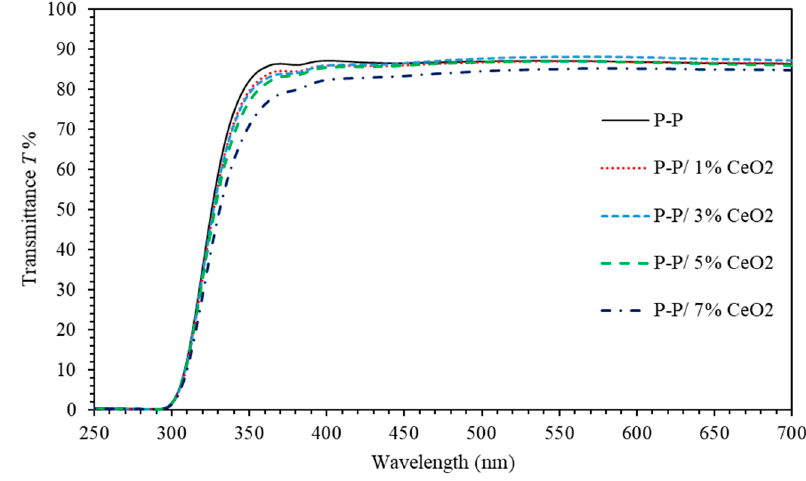
Figure 1. The transmittance of (PMMA-PS)/CeO 2 nanocomposite thin films incorporated with different CeO 2 NPs concentrations.